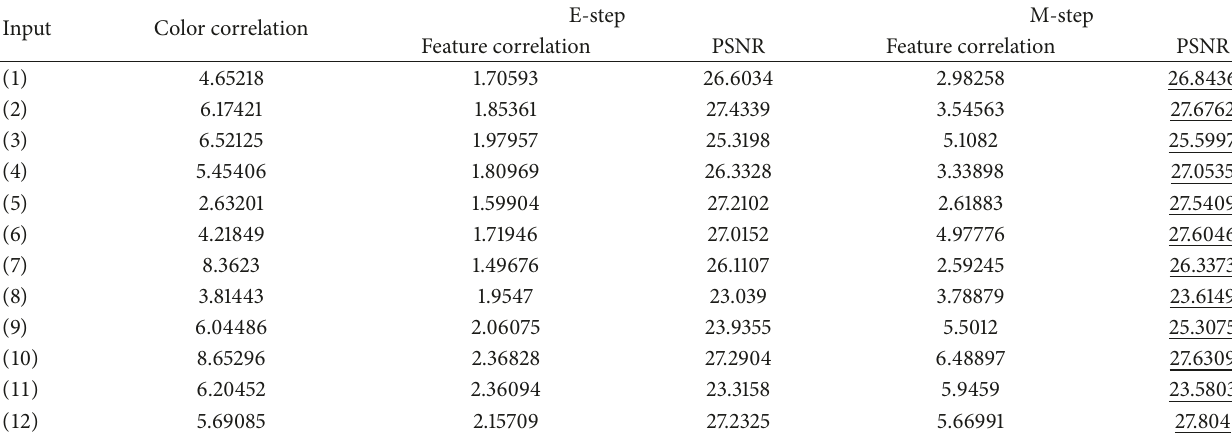
Table 1: The results of learning process before and after applying M-step.